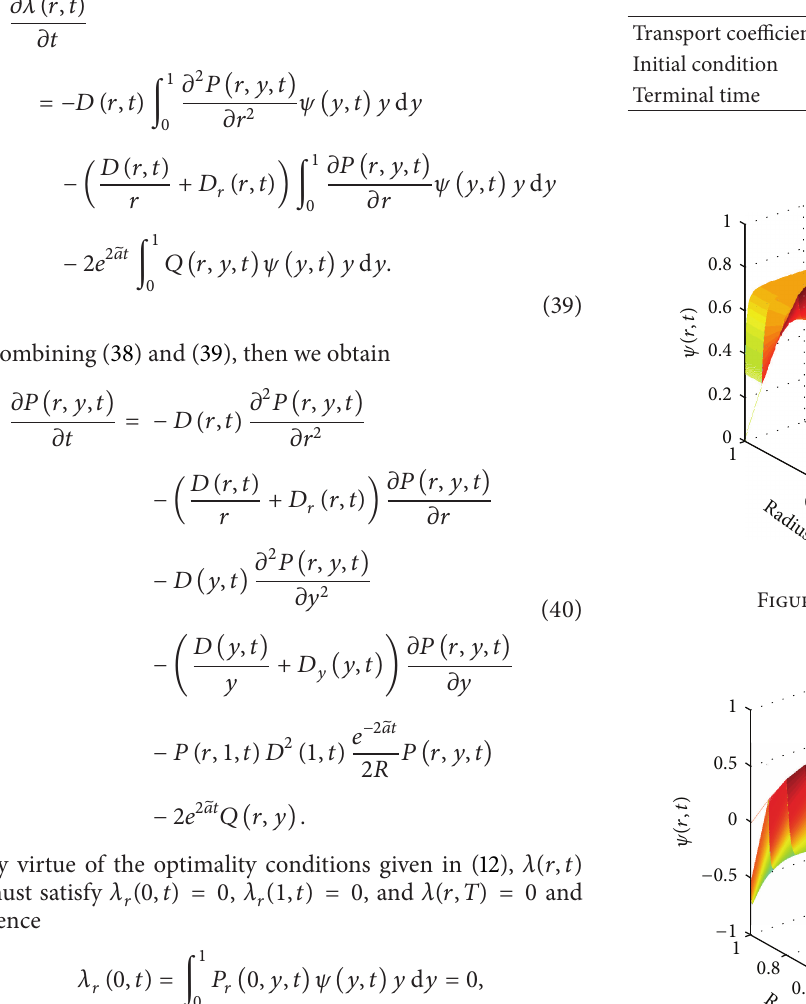
Table 1: Coefficient functions and parameters for numerical simu- lation example.